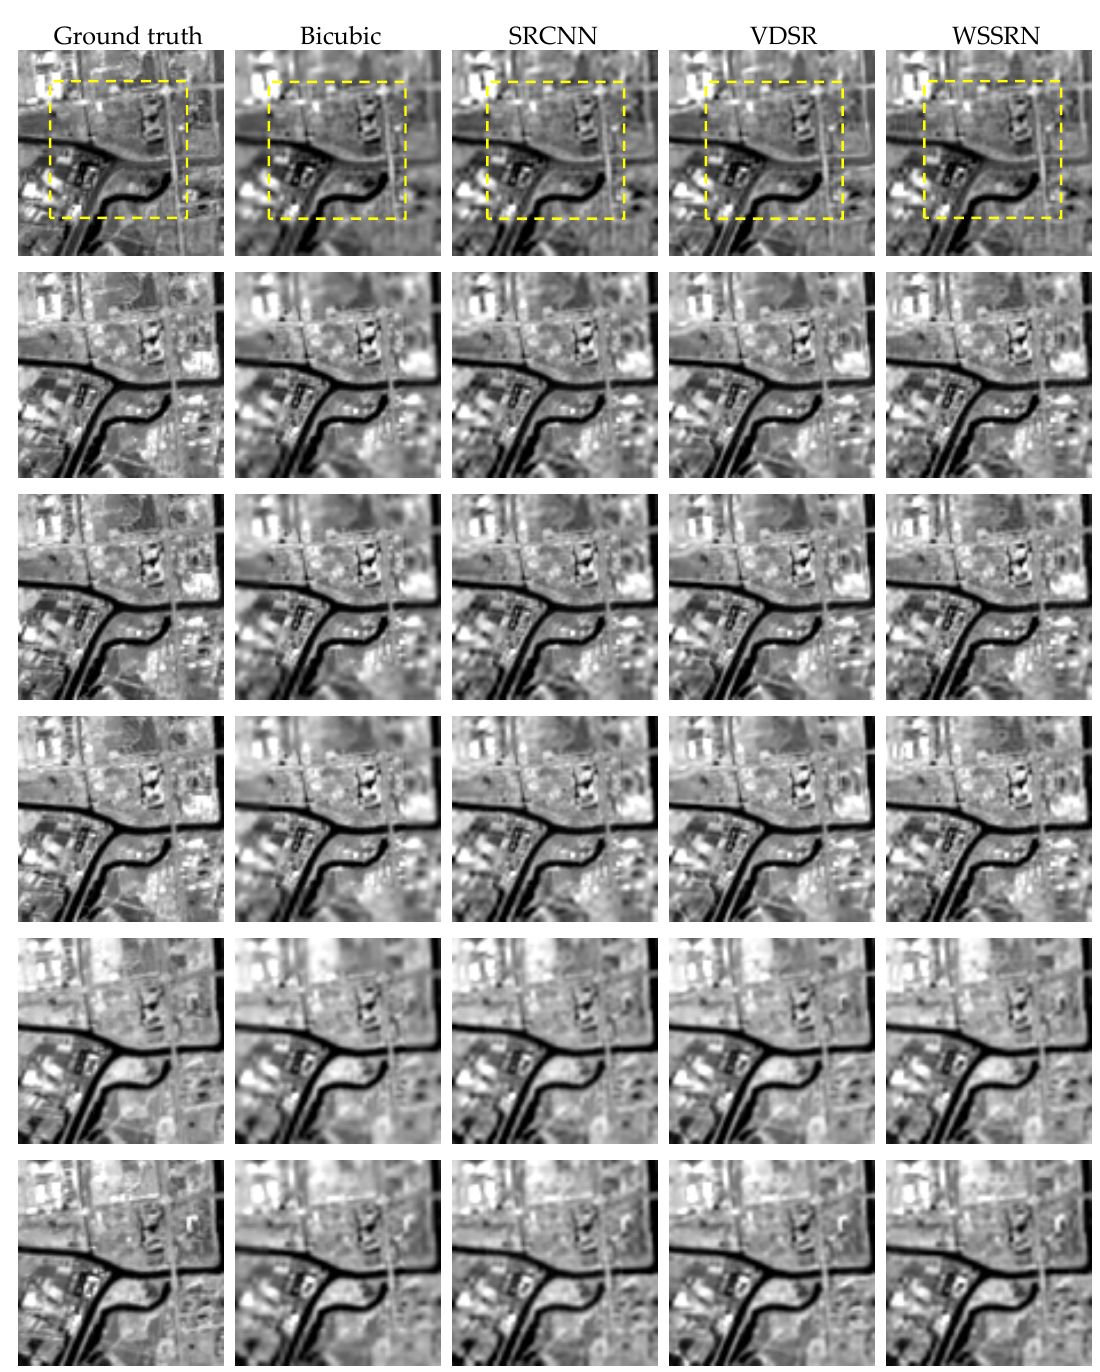
Figure 14. Visual performance after the replacement. Each row belongs to one band. From top to bottom: band 5, band 6, band 7, band 8a, band 11, and band 12. The overlapping area is framed by a dotted yellow line. Due to the insu ffi cient extraction of spatial detail information, when the overlapping region is replaced with the image patch with rich HR information, the results fused by the bicubic, SRCNN, and VDSR methods show a poor fusion e ff ect in the surrounding area. In addition, the results of VDSR show a great di ff erence in the fusion e ff ect